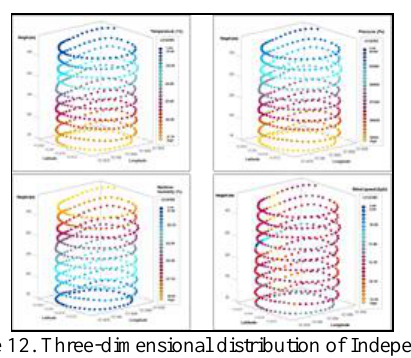
Figure 12. Three-dimensional distribution of Independent Variables Temperature (upper left), Pressure (upper right), Relative humidity (lower left), Wind speed (lower right)